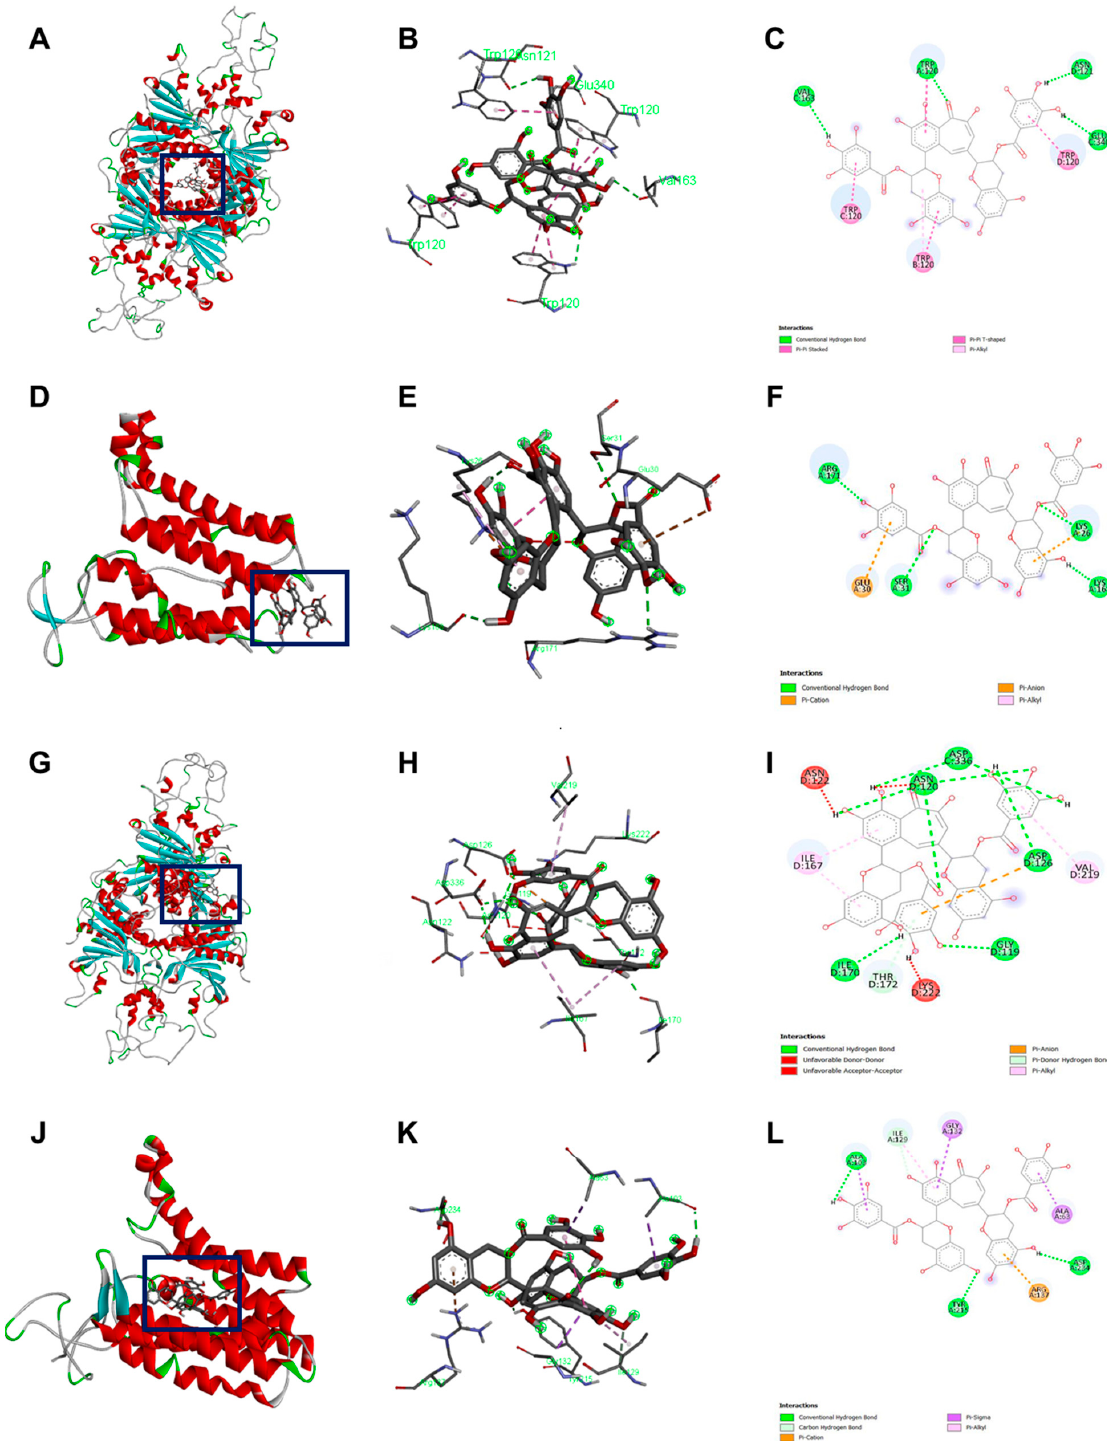
Figure 6. Docking visualization of TFDG with the germination protein using BIOVIA Discovery Studio Visualizer. ( A – C ) B. cereus GPR with TFDG; ( D – F ) B. cereus Lgt with TFDG; ( G – I ) B. subtilis GPR with TFDG; ( J – L ) B. subtilis Lgt with TFDG. For ( C , F , I , L ) the bright green line shows conventional hydrogen bond; bright pink shows the pi-pi interaction; light pink shows pi-alkyl interaction; orange shows pi cation, pi carbon, and pi-anion interaction; the red line shows unfavorable bond interaction; light green shows pi-donor hydrogen interaction and carbon-hydrogen interaction; and bright purple shows pi sigma interaction.